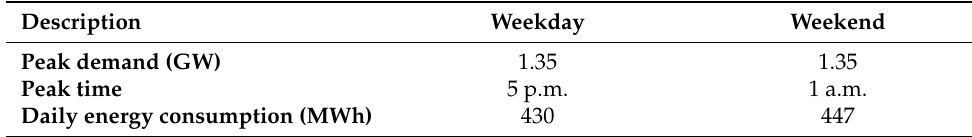
Table 3. Expected Power and Energy Addition of 1 million EVs.